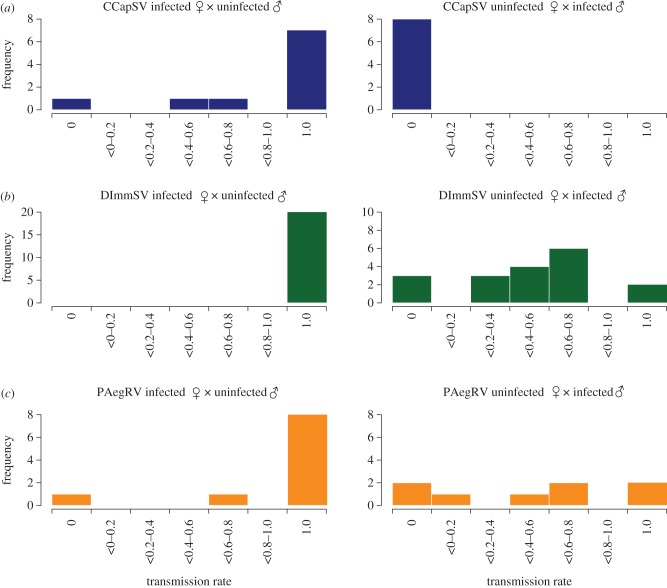
Vertical transmission rates of three sigma viruses from infected females (left) and males (right). (a) CCapSV, (b) DImmSV, (c) PAegRV. The far left and far right bins are individuals with zero or 100% transmission respectively. Results from control crosses where both parents were uninfected are not shown. (Online version in colour.)